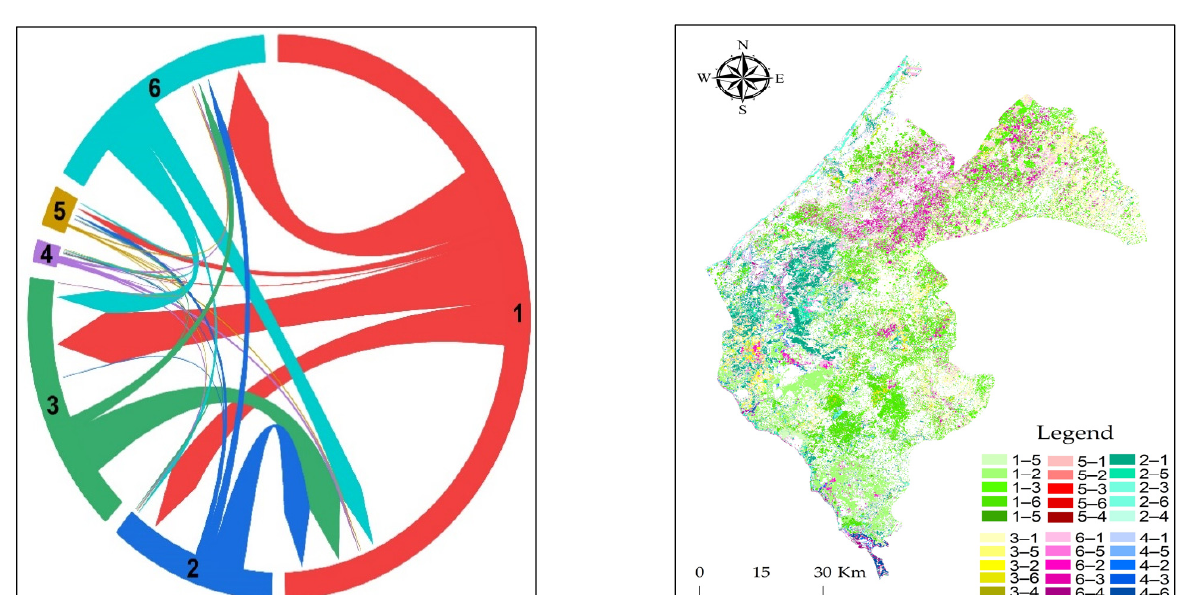
Figure 2. Characteristics of transition of agricultural land use from 2000 to 2020: (1) agricultural land; (2) ecological land; (3) grassland; (4) wetland; (5) construction land; and (6) unused Table 5. Results of the transfer matrix of land use transition (km 2 ) in the Thiès region, 2000 to 2020 .